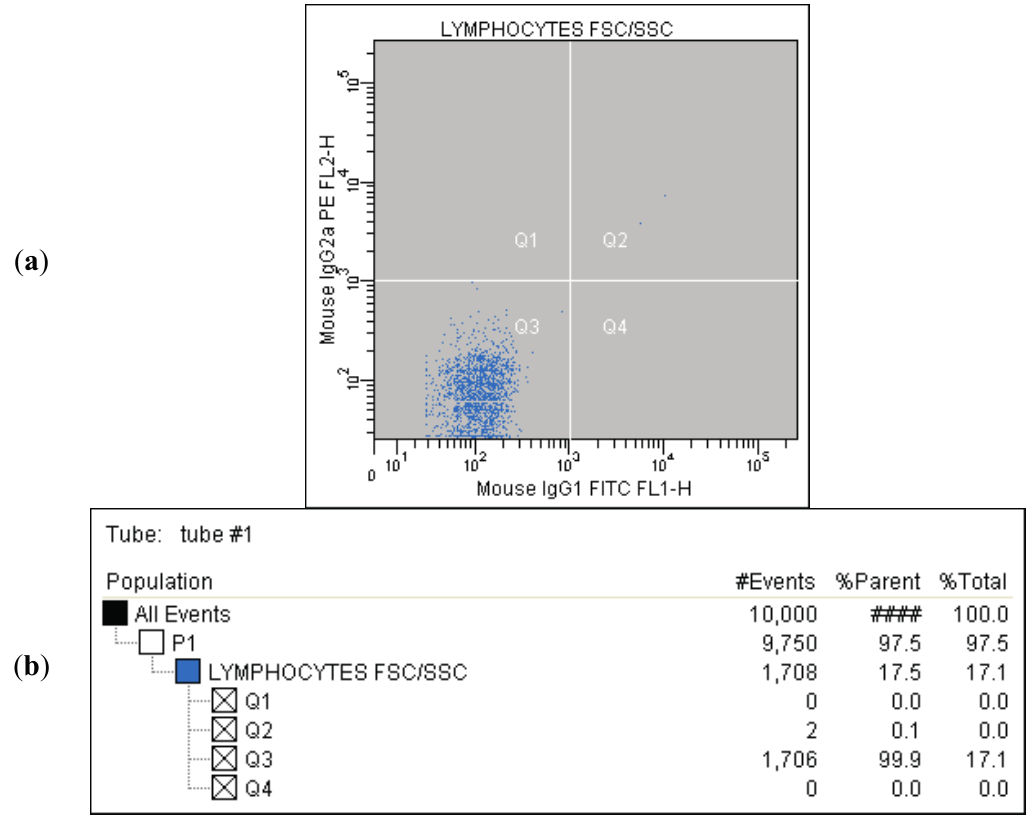
Figure 2. ( a ) Tube No. 1; Dot plot of MouseIgG1 fluorescein isothiocyanate (FITC)/MouseIg2a phycoerythrin (PE) with quadrant markers, showing negative control; ( b ) Tube No. 1; Gating tree showing gating strategy for Fluorescence-activated cell sorting (FACS) analysis as well as parent and total cell percentages within each of the gates for negative